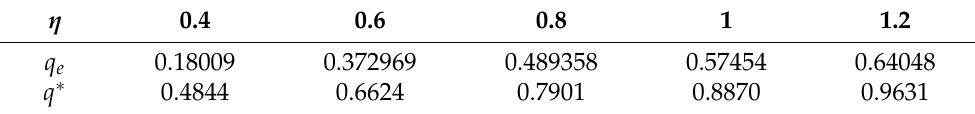
Table A2. Comparison of q e and q ∗ values against service rate of secondary users η